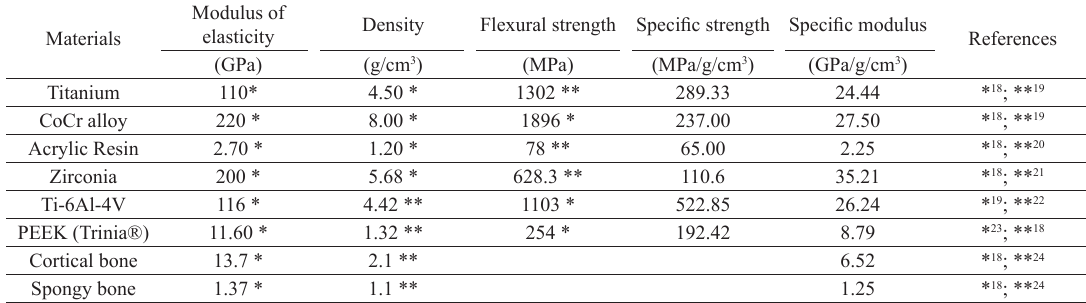
Table 1 - Mechanical properties of various materials applied in Dentistry.